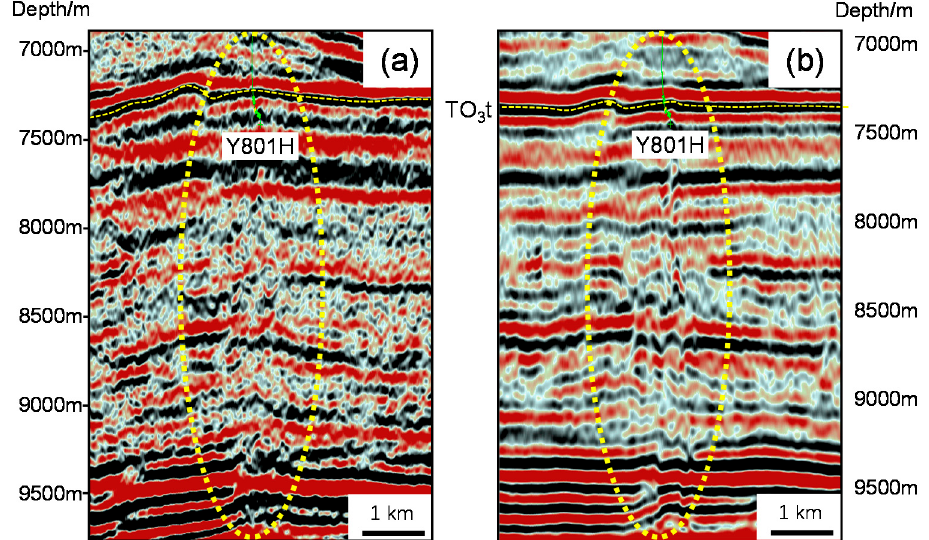
Figure 5. Comparison between ( a ) the conventional pre-stack processing depth section and ( b ) the new processed depth section in the Fuman Oilfield (the yellow circle showing the fault zone; TO 3 t: base of Upper Ordovician).